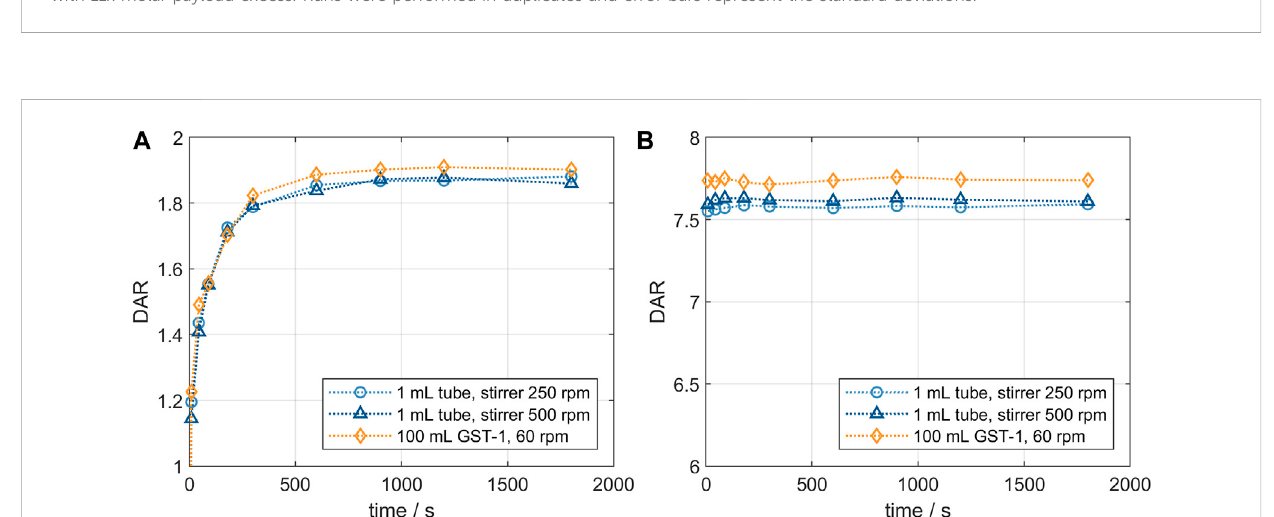
FIGURE 2 Comparisonofthesmall-andlab-scaleDARconjugationkineticsdeterminedbyRP-UHPLC. (A) KineticsforADC1at5 mg/mLand5xmolarpayload excess and (B) kinetics for ADC2 at 20 mg/mL and 11x molar payload